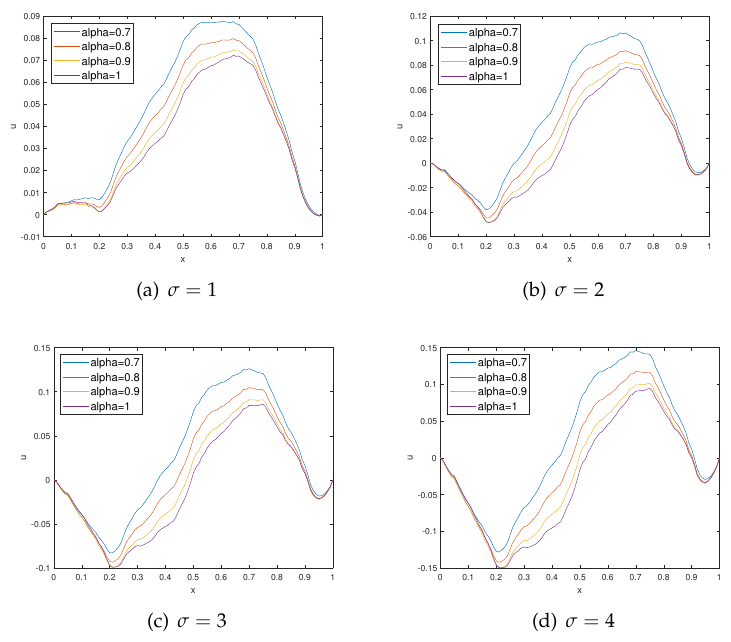
Figure 12. The approximation solutions of Example 2 (case (3)) with t =